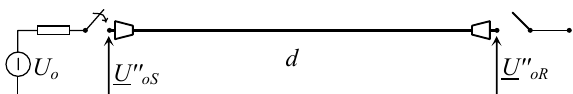
Figure 3. No load energization at port